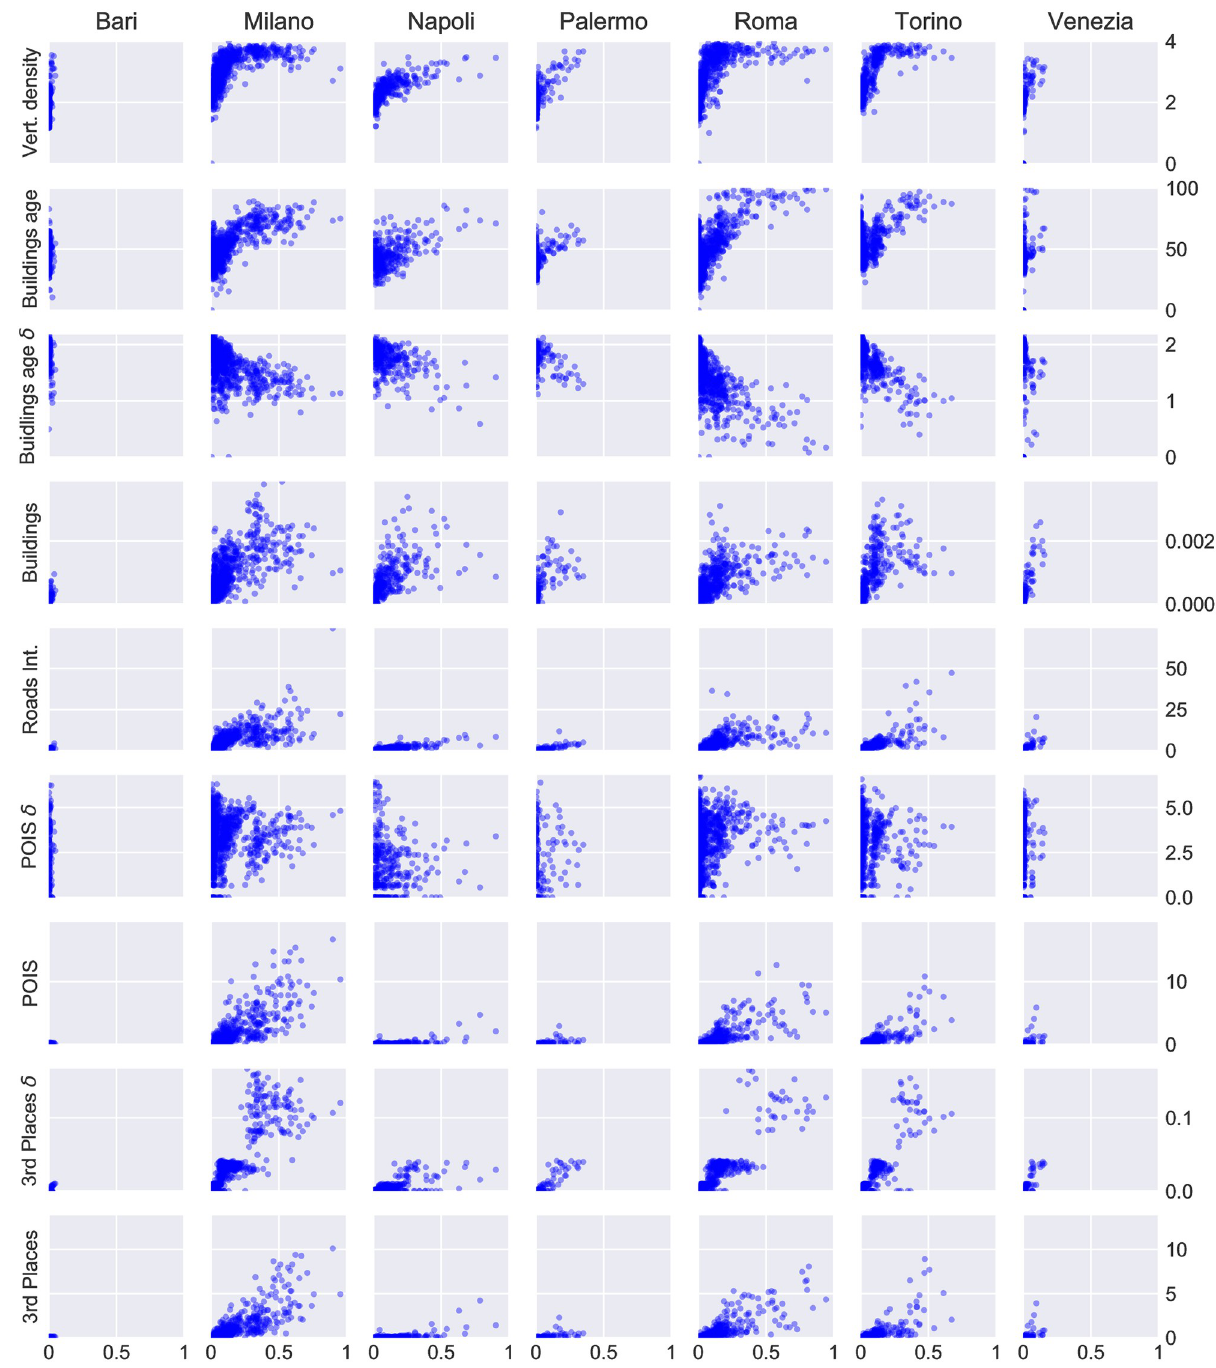
Fig 2. Relationship between presence of people and geographic features. In these scatter plots each point represents a cell in each city. The x-axis encodes the presence of all age groups aggregated together, whereas the y-axis represents the values for each feature described in the Data section. All quantities are normalised by the area of the cell. The points are plotted with some transparency so that accumulation of multiple cells with similar values looks slightly darker.